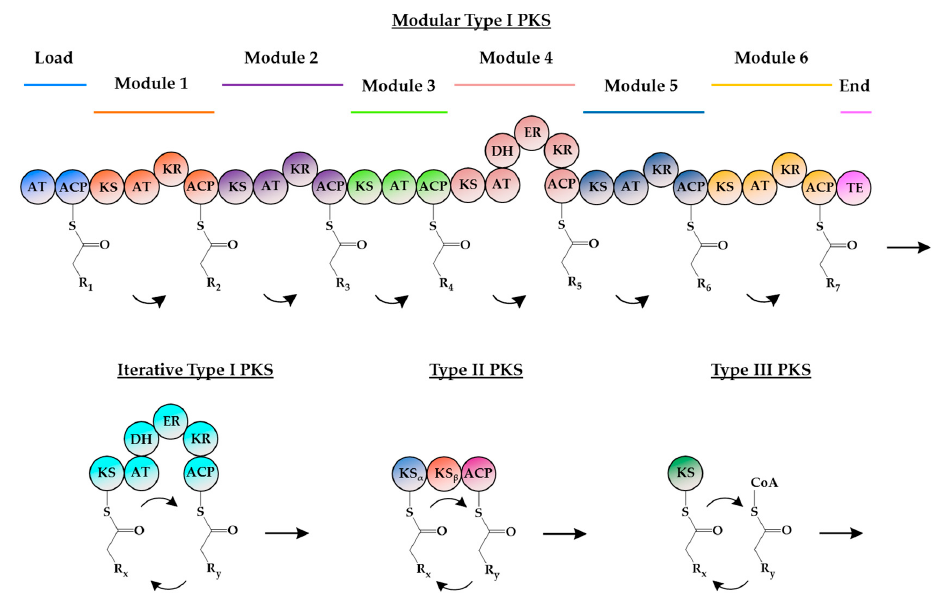
Figure 2. Domain organization of the different PKSs. Putative domains are represented by circles. In